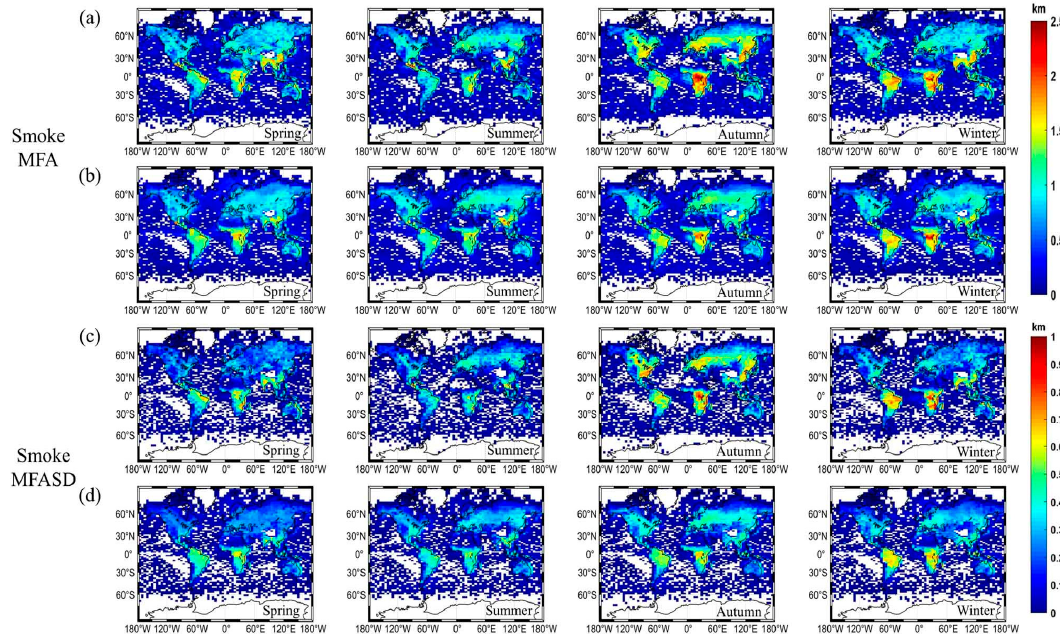
Figure 11. Comparisons between model predictions and CALIPSO observations for the smoke aerosol. ( a ) CALIPSO observed MFA; ( b ) model predicted MFA; ( c ) CALIPSO observed MFASD; ( d ) model predicted MFASD. White shading indicates insufficient available data.